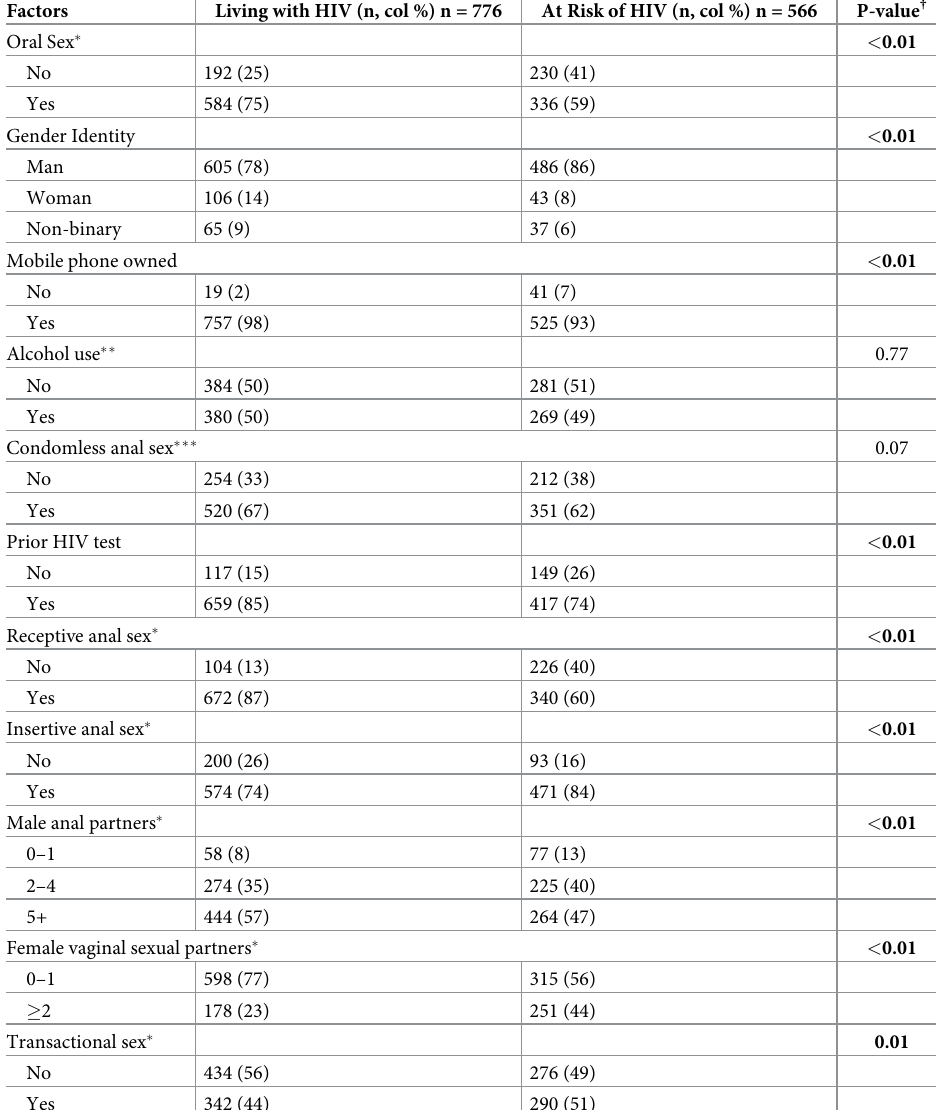
Table 1. Demographic and behavioral characteristics of Nigerian MSM and TGW stratified by HIV status. Factors Living with HIV (n, col %) n = 776 At Risk of HIV (n, col %) n = 566 P-value †